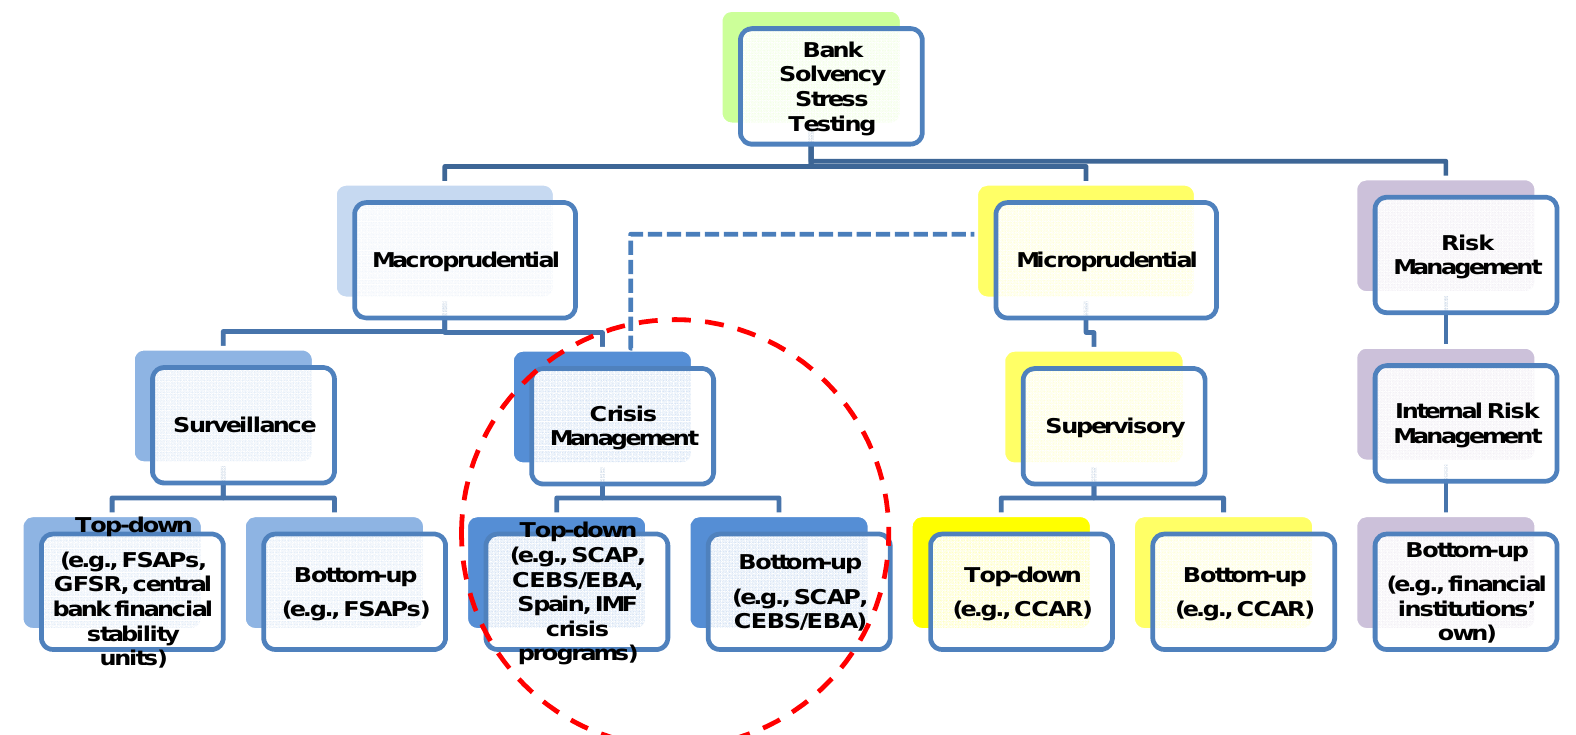
Figure 1. Solvency Stress Testing